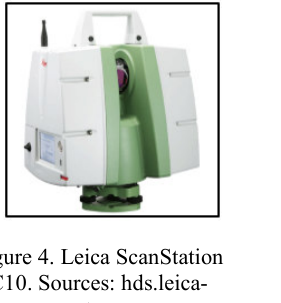
Figure 4. Leica ScanStation C10. Sources: hds.leica- geosystems.com